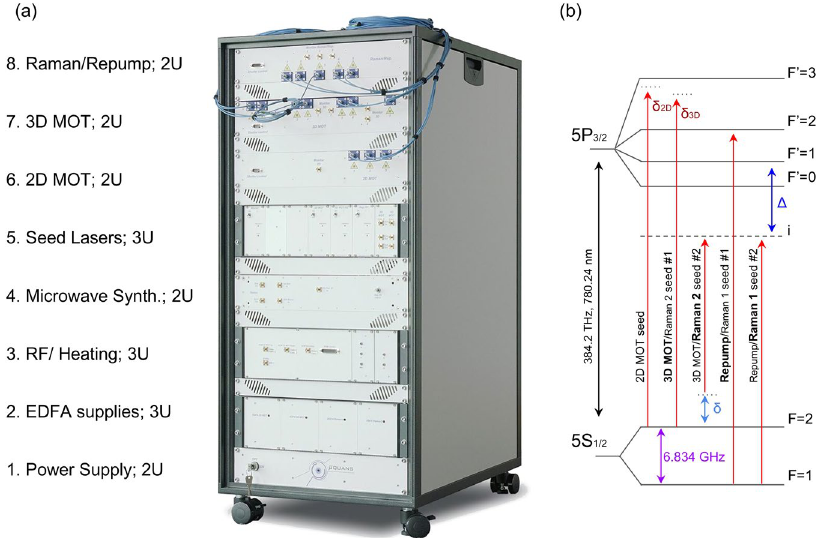
Figure 1. ( a ) The automated laser system inside of a typical mobile 19 ″ rack, without thermal/condensation shroud. There are eight 2U and 3U rack units with the following functions, from bottom to top: the power supply converting 230 V AC to various DC voltages (1), the high power EDFA controllers (2), a combined unit of RF components and temperature servos (3), a dedicated microwave frequency unit (4), cubbyholes for the lasers and associated electronics (5), the 2D MOT micro-optic module with integrated PPLN crystal and shutter (6), 3D MOT micro-optic module with integrated AOMs, PPLN crystal, and shutters (7), and the Raman/ Repump micro-optic modules with integrated AOMs, PPLN crystals, and shutters (8). ( b ) Seed lasers locking frequencies relative to 87 Rb D 2 transitions. Cooling inside the 3D MOT and driving Raman transitions employ the same pair of seeds 3D MOT/Raman 2 and Repump/Raman 1, by changing their frequency set-point. We label #1 and #2 as the corresponding set-points configurations. Configuration #1: the 3D MOT/Raman 2 seed is red-detuned δ 3D from the F = 2 to = ′ F 3 transition, and the Repump/Raman 1 seed is tuned to be resonant to the F = 1 to = ′ F 2 transition. Configuration #2: the 3D MOT/Raman 2 seed is red-detuned by Δ (GHz) from the F = 2 to = ′ F 1 transition, and the Repump/Raman 1 seed is red-detuned by Δ from the F = 1 to = ′ F 1 transition. We scan the frequency of the Raman transition, with respect to the hyperfine splitting 6.834 GHz, by applying δ (kHz to MHz). The 2D MOT seed laser is red-detuned δ 2D < δ 3D from the F = 2 to = ′ F 3 transition. For this seed, the repump frequency is addressed for the 2D MOT by frequency modulation with an